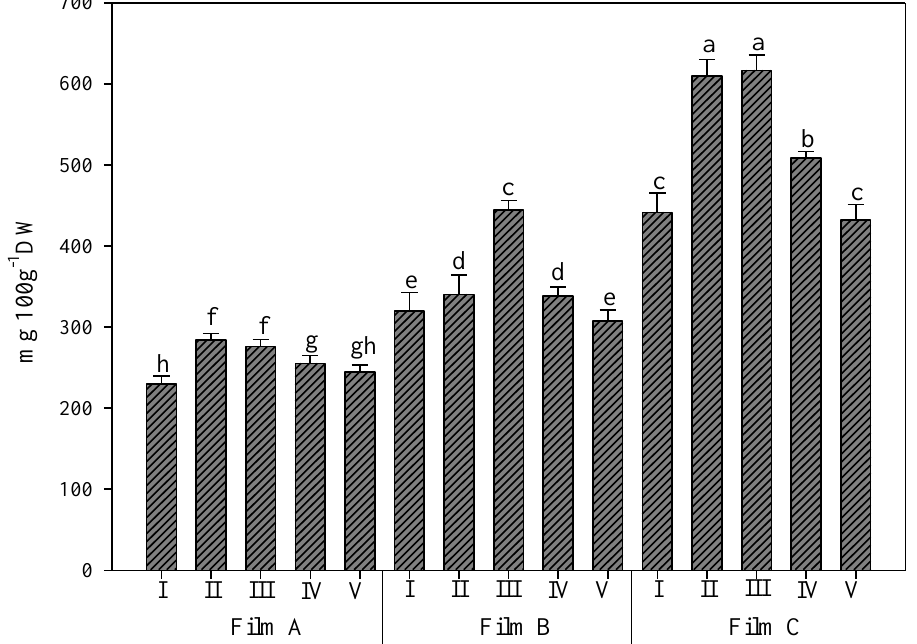
Figure 3. Chlorophyll b content (mg/100 g of dry weight D.W.) in wild rocket leaves as affected by interaction between greenhouse cover film (Film A: diffused light film; Film B: clear film; Film C: diffused light film with UV-B window) and UV-B applications (I: not treated with UV-B; II: treated with UV-B for 45 s; III: treated with UV-B for 150 s; IV: treated with UV-B for 330 s; V: treated with UV-B for 660 s). Vertical bars indicate standard error; different letters indicate significant differences according to Tukey’s test ( p ≤ 0.05).